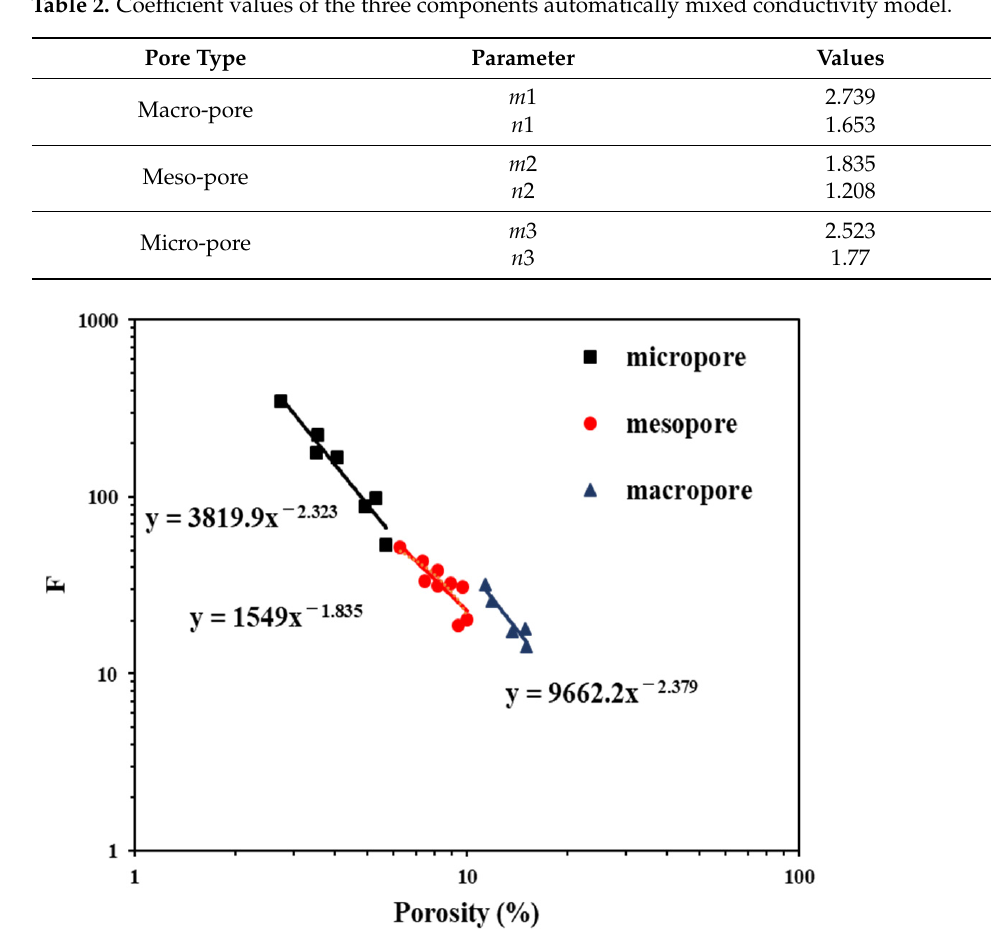
Figure 22. Relationship between formation factors and porosity.